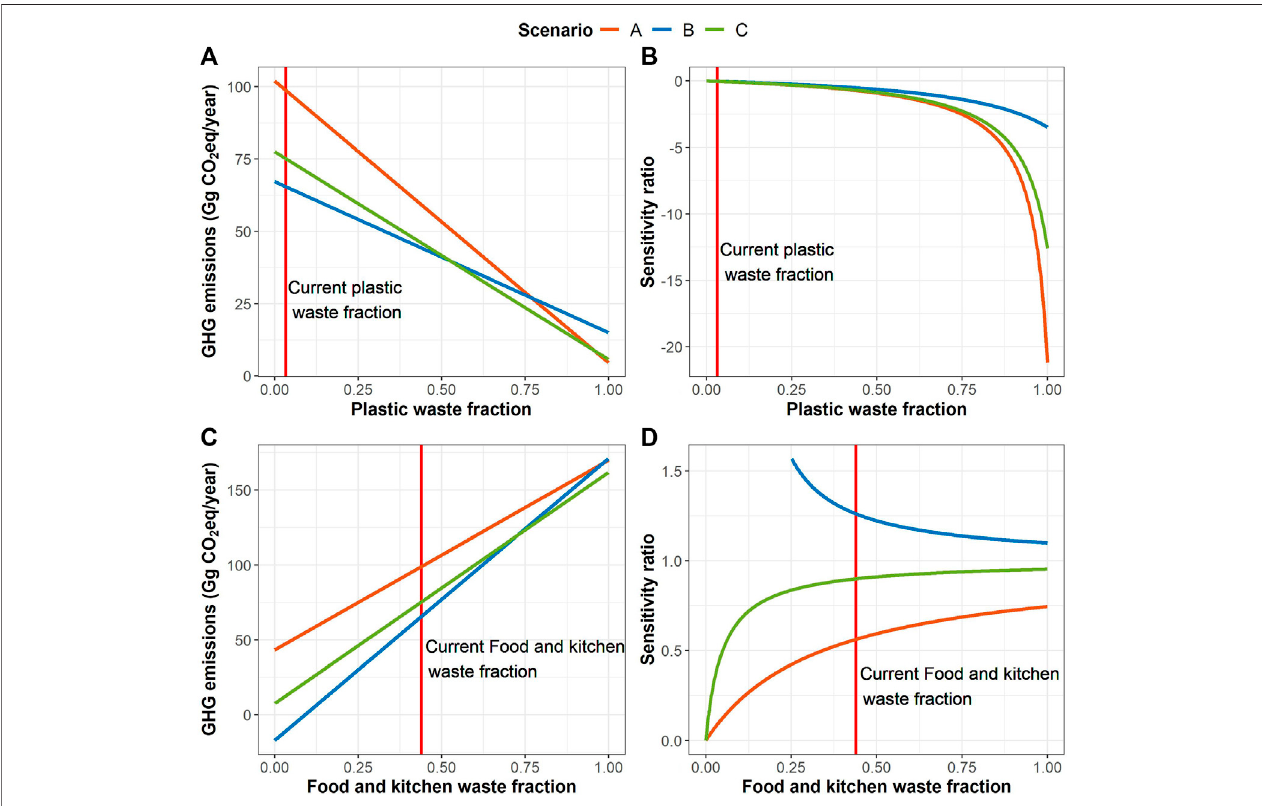
FIGURE 7 | Sensitivity analysis of food and kitchen waste and plastic waste fractions and their impact on the net GHGs emissions and scenario performance: (A) Plastic waste fraction; (B) Sensitivity ratio behavior with respect to the plastic waste fraction content; (C) Food and kitchen waste fraction; (D) Sensitivity ratio behavior with respect to the food and kitchen waste